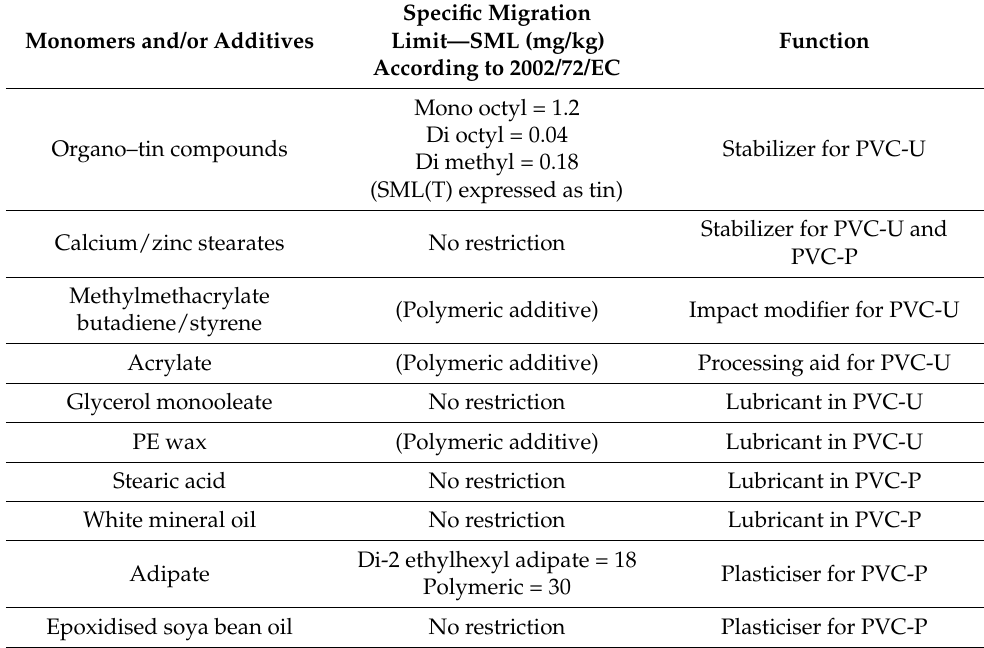
Table 9. Monomers and additives used in PVC manufacturing for food packaging. Adapted from Table 2 in reference